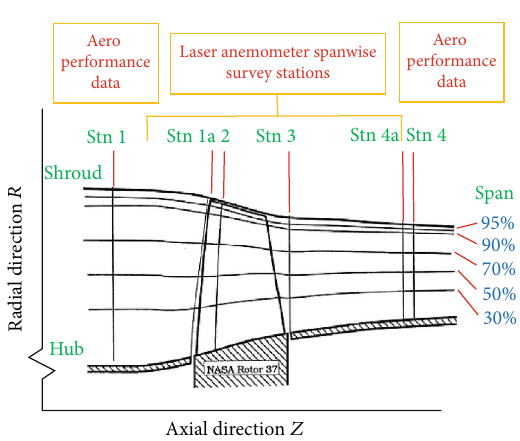
Figure 2: Meridional view of laser anemometer and aerodynamic survey locations for Rotor 37